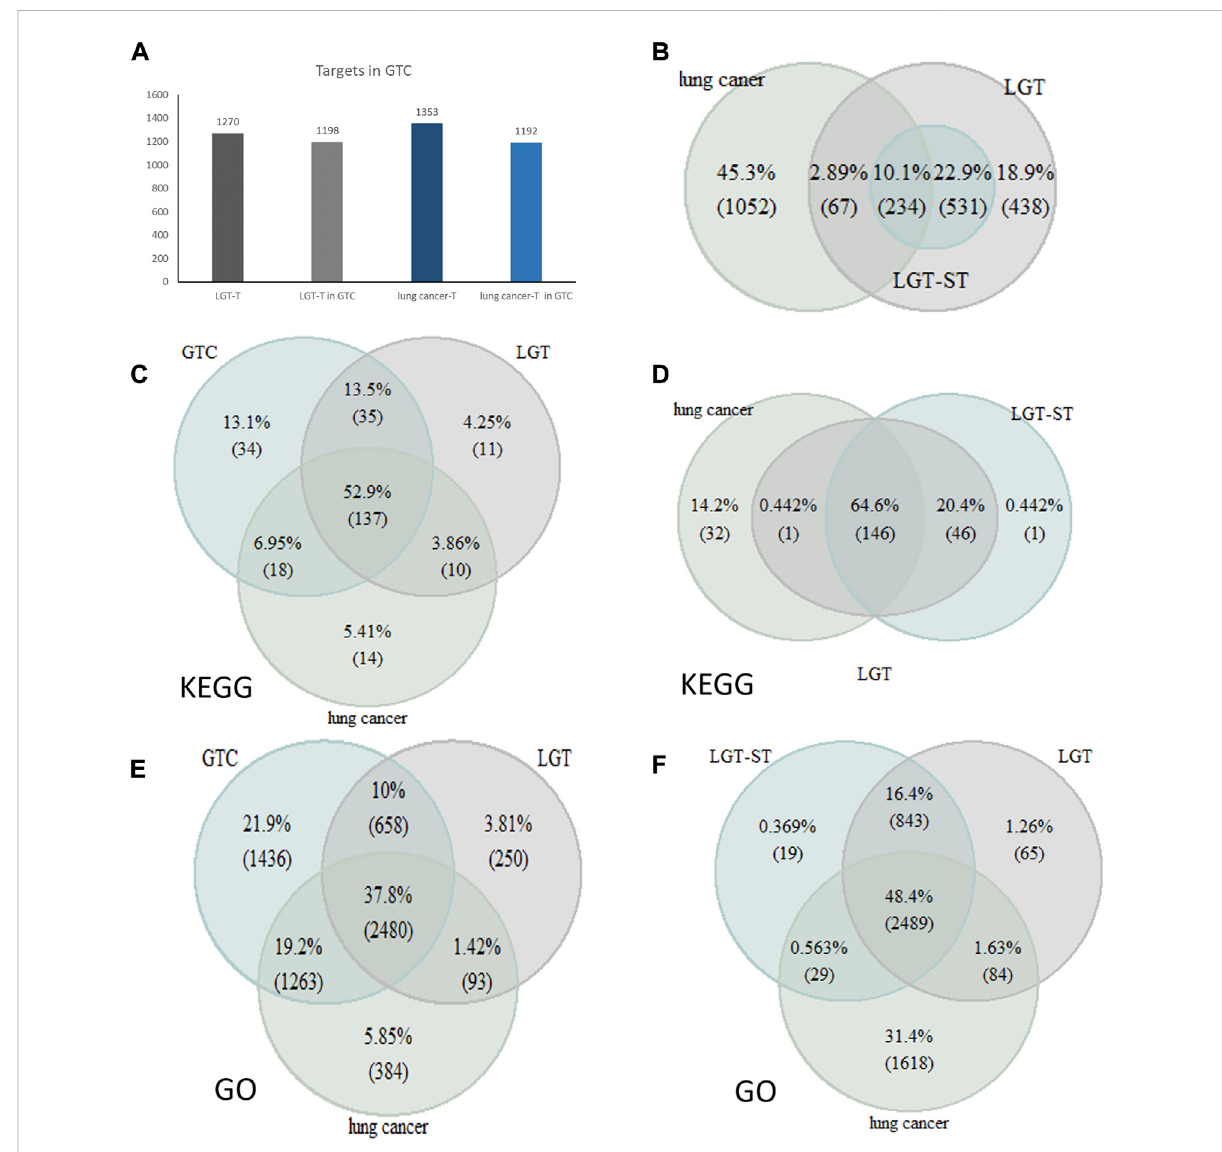
FIGURE 6 Validation of quantitative ef fi cacy-toxicity network of LGT. (A) The number of LGT targets and lung cancer targets in the GTC; (B) Number of overlappinggenes ofLGT, Lungcancer andLGT-ST; (C,D) :Coverage ofpathway analysis betweenLGTtargets and lung cancer targetswithGTC (C) and LGT-ST (D) ; (E,F) : Coverage of GO function enrichment between LGT targets and lung cancer targets with GTC (E) and LGT-ST (F)